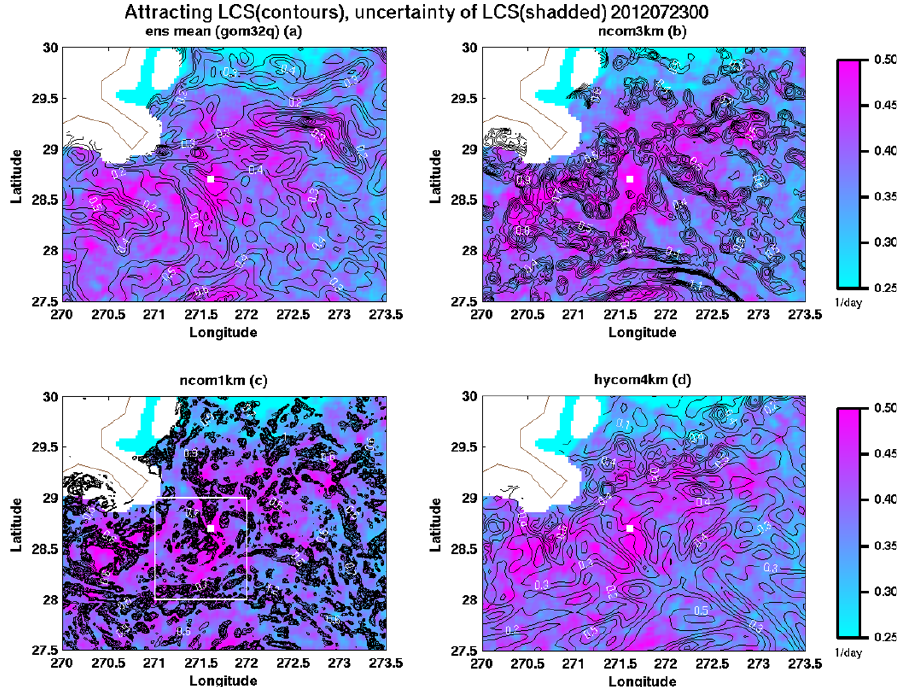
Fig. 13. The same as Fig. 12, but for attracting